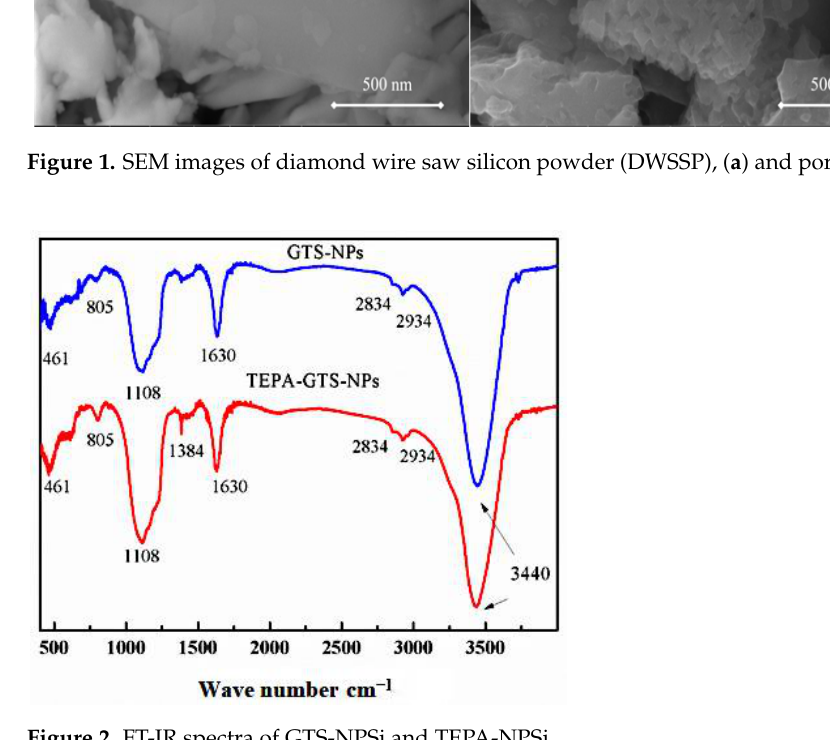
Figure 2. FT-IR spectra of GTS-NPSi and TEPA-NPSi.